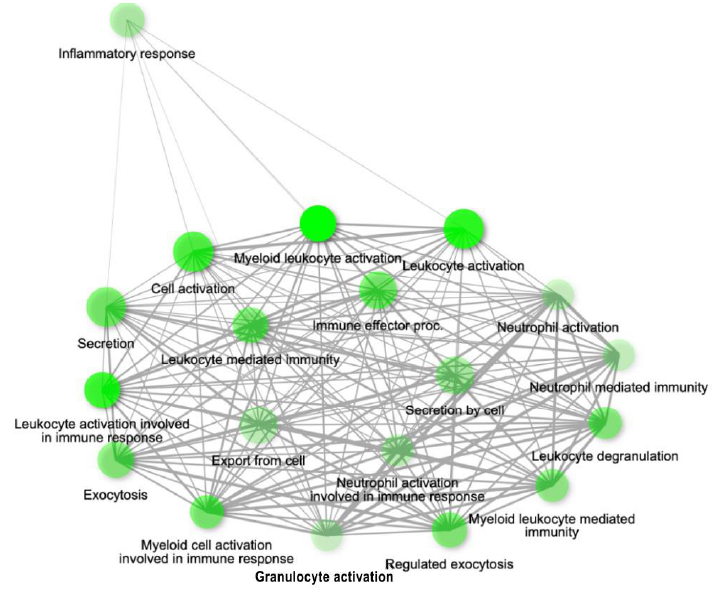
Figure 12. Gene network for top 20 enriched pathways for genes module, MEcyan based on GO biological process annotation.